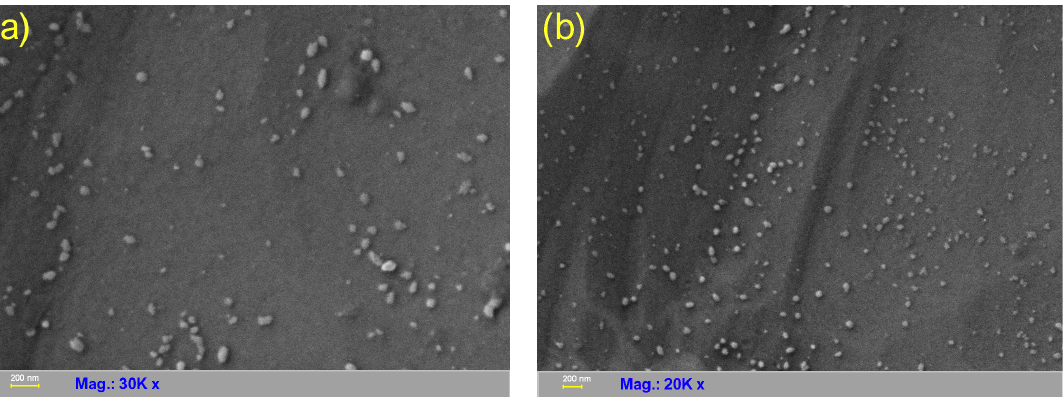
Figure 7. HR-SEM micrographs ( a ) 30 K magnification and ( b ) 20 K magnification recorded the prepared CDs.